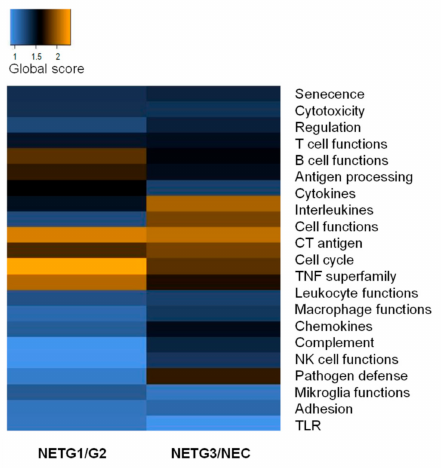
Figure 2. Di ff erential expression at the gene set level in NET G1 / G2 and NET G3 / NEC. For each gene set the most di ff erentially expressed genes were compared to healthy tissue and the extent of di ff erential expression in each gene set was summarized using a global significance